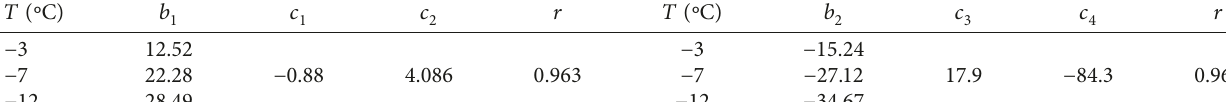
, c , c , and c and the correlation coefficient r 1 2 3 4